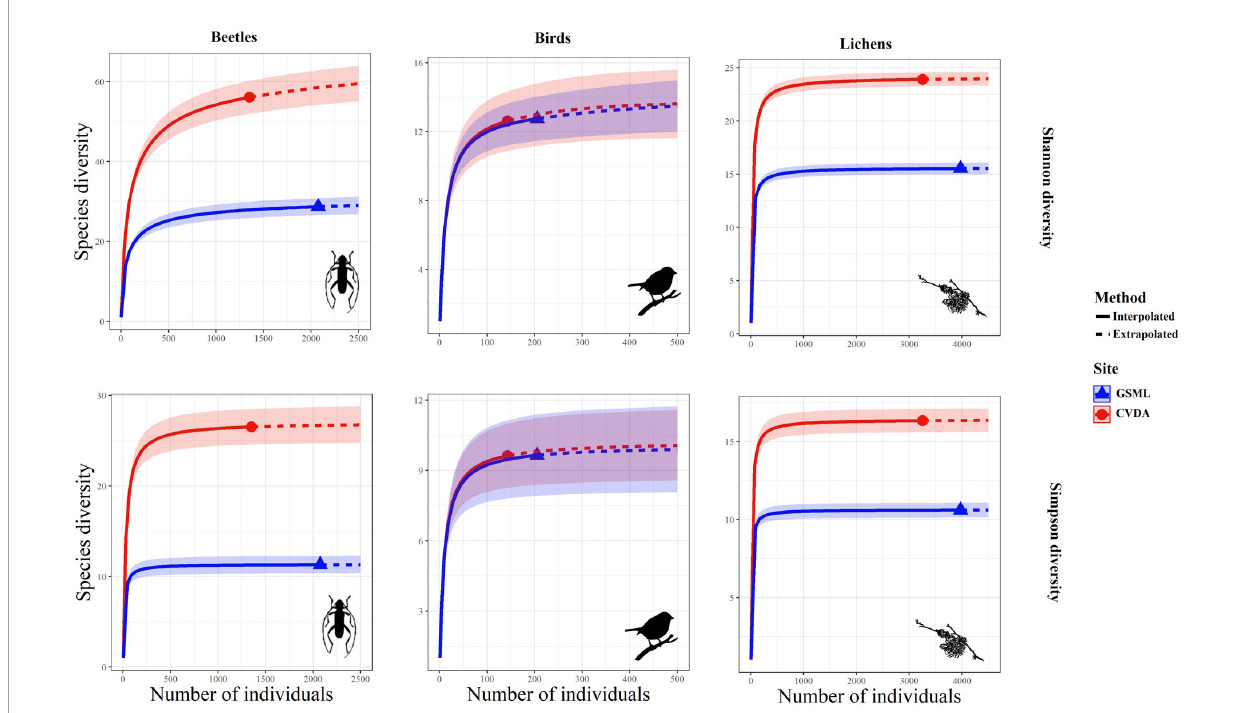
FIGURE3 Rarefaction curves with 95% confidence intervals (shaded areas) for two biodiversity indices (Shannon and Simpson) for the three taxa considered.